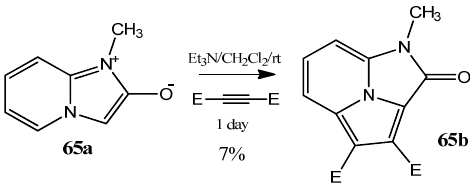
Scheme 32. Synthesis of azacyclazinone from mesoionic